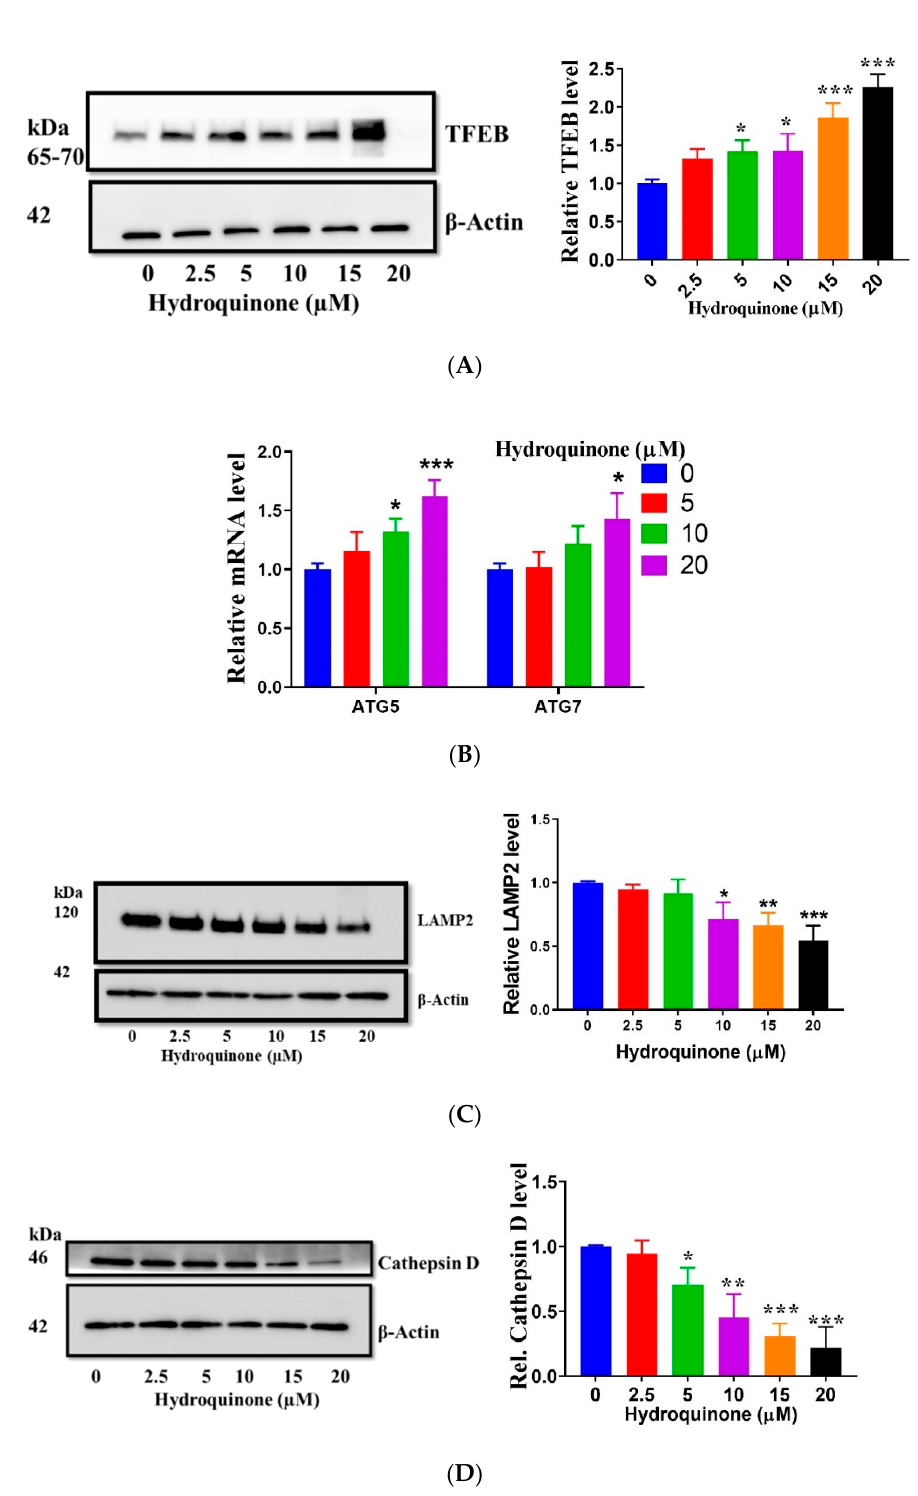
Figure 4. Effect of hydroquinone (HQ) on mRNA and protein markers of the autophagy-lysosomal pathway. ( A , B ) Overexpression of TFEB protein and elevated mRNA levels of ATG5 and ATG7 in ARPE-19 incubated with HQ for 2 h. ( C , D ) Immunoblots for LAMP2 and cathepsin D levels in whole-cell lysate from cells exposed to HQ for 2 h. Densitometric quantification of protein levels was normalized to β -actin and expressed as a ratio of the control. Data represent the mean + SD of 3 independent experiments of 3 replicates each. Statistical analysis using one-way ANOVA followed by Dunnett’s multiple comparison test. * p < 0.05, ** p < 0.01, *** p < 0.001, significant difference relative to the